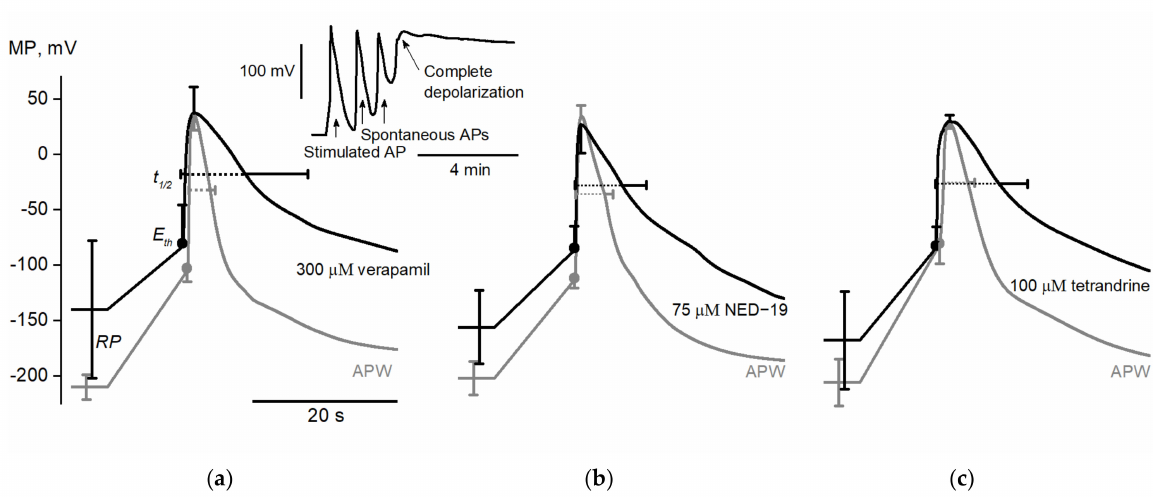
Figure 1. Average electrically evoked action potentials of Nitellopsis obtusa internodal cells in artificial pond water (APW) with standard conditions and after exposure to different inhibitors of human two-pore channels (TPCs): ( a ) APs after exposure to 300 µ M verapamil. The upper insert represents spontaneous APs after electrical excitation (indicated by arrows) and subsequent complete depolarization of membrane potential; ( b ) APs after exposure to 75 µ M NED-19; ( c ) APs after exposure to 100 µ M tetrandrine. Horizontal bars indicate SD of t dep and t rep ; vertical—resting potential ( RP ), excitation threshold ( E th ), and peak potential V max for each drug n = 6 −